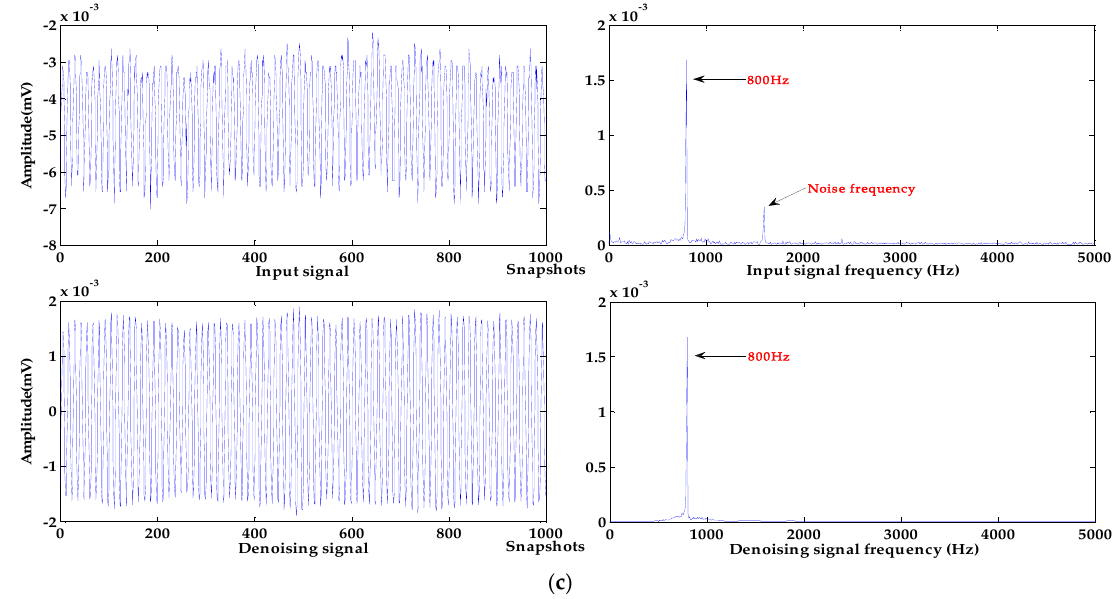
Figure 12. Processing results of different measured signals. ( a ) sound source frequency 315 Hz; ( b ) sound source frequency 500 Hz; ( c ) sound source frequency 800 Hz.